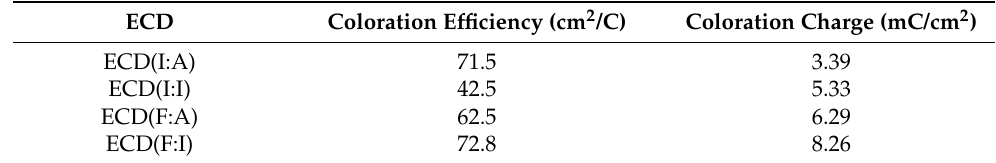
Table 2. Summary of the calculated coloration efficiency and charge values of the ECDs with various TCOs.